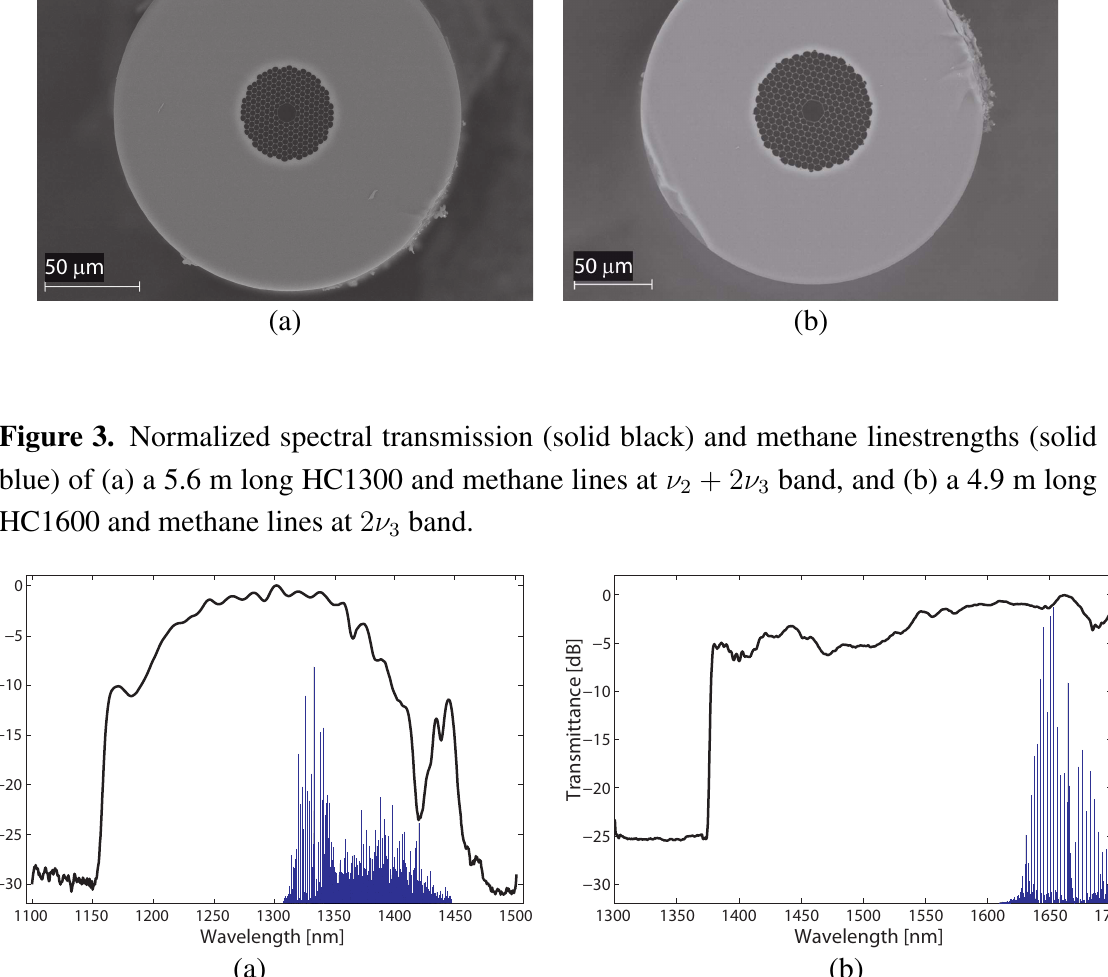
Figure 2. SEM micrographs of the cross-section of the (a) HC1300 fibre and (b) HC1600 fibre.